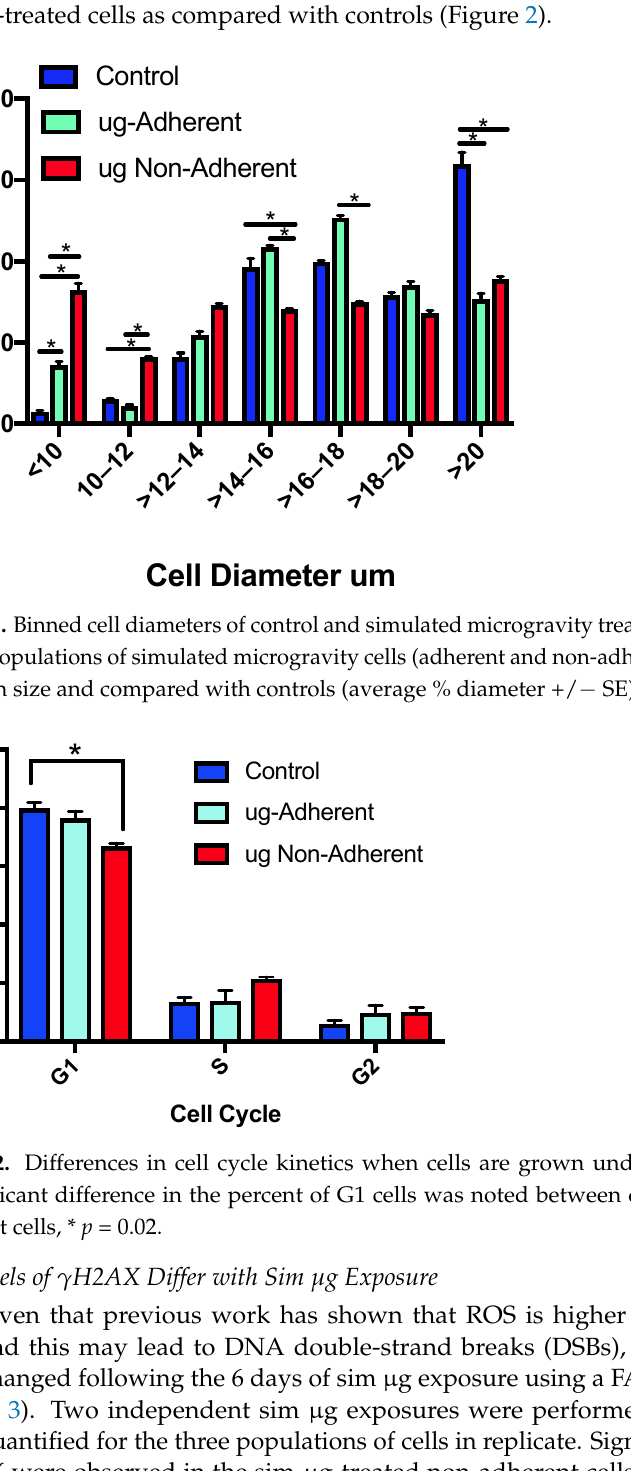
adherent vs. non-adherent). The control and sim- µ g-treated adherent cells showed fairly similar, lower levels of γ Figure 2. Di ff erences in cell cycle kinetics when cells are grown under simulated microgravity. A signi fi cant di ff erence in the percent of G1 cells was noted between control and sim-µg-treated ad- herent cells, * p = 0.02.